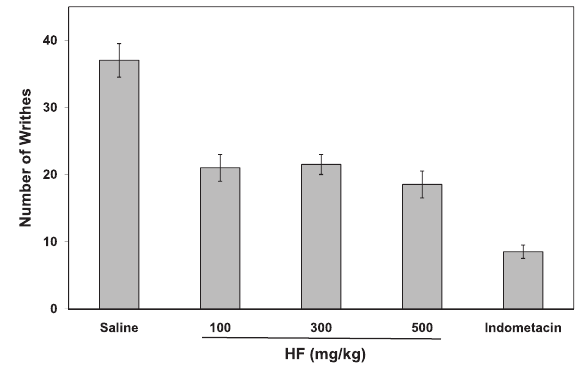
Fig. 2 - Analgesic effect of HF on the writhing response induced by acetic acid 0.6% in mice. Indometacin 5 mg kg -1 was used as standard.